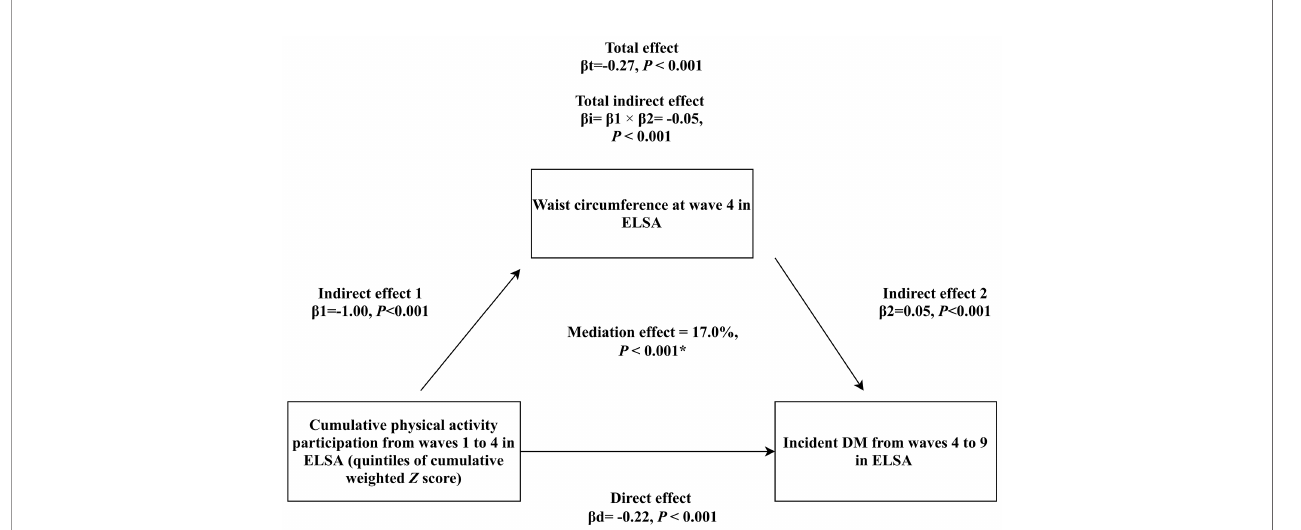
FIGURE 4 | Mediation analysis assessing the mediating role of waist circumference measured at wave 4 in the association of cumulative weighted global physical activity Z score quintiles on subsequent incident DM. b d: coef fi cient for direct association of cumulative weighted global physical activity Z score quintiles